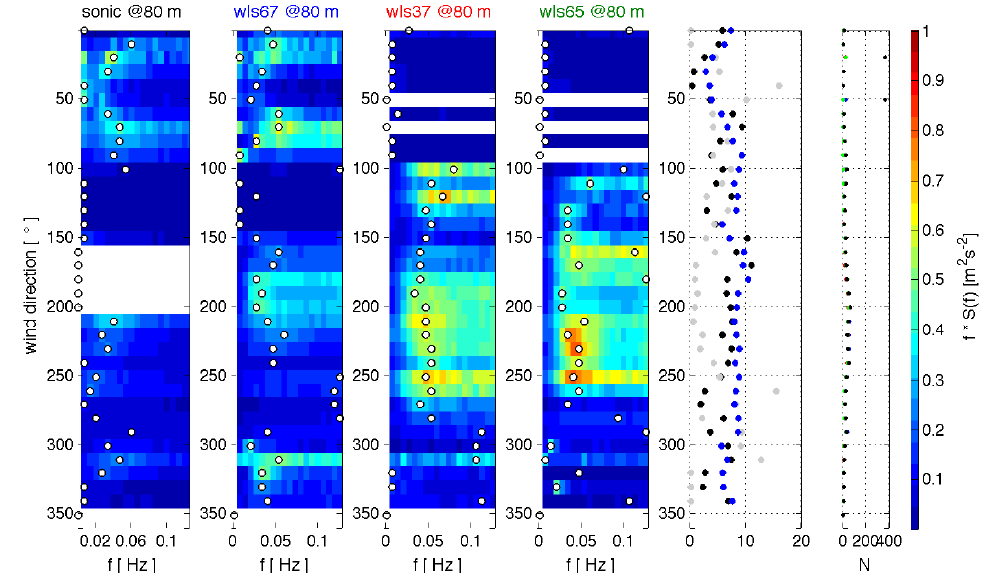
Figure 12. Composites of hourly energy spectra of u at 80m for all wind direction bins from wls67, wls37 and wls65 (from left to right) filtered for stable wind conditions. White circles indicate the maximal spectral energy density of each direction bin. Additional subplots show wind direction bin averaged horizontal wind speeds at 108m (blue in (m · s − 1 ), power output (black in (MW/100)) and blade pitch angle (gray in ( ◦ )) of wind turbine WT6 and the number of averaged hours in each bin for wls67 (blue), wls37 (red) and wls65